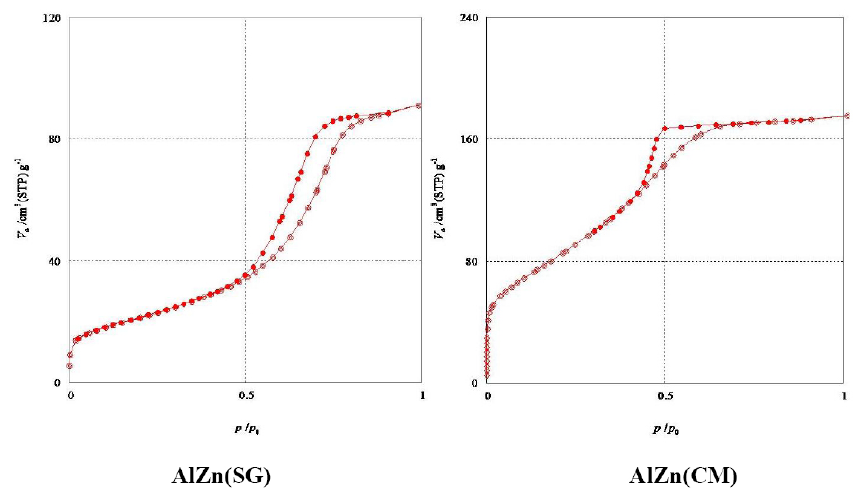
Figure 1. Nitrogen sorption isotherms of the support prepared by different methods. Table 1. Physicochemical characteristics of the supports and